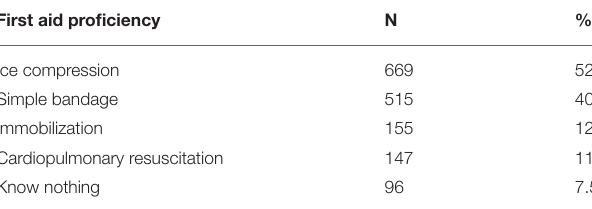
TABLE 4 | Students’ proficiency of first aid